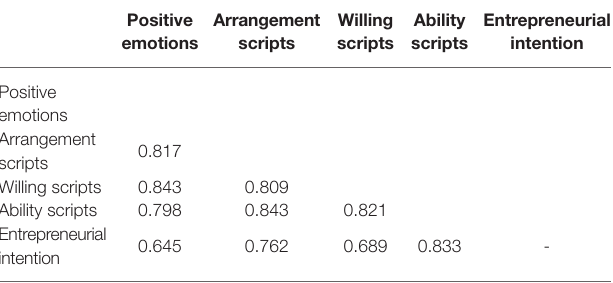
TABLE 7 | The Heterotrait-Monotrait ratio of correlations